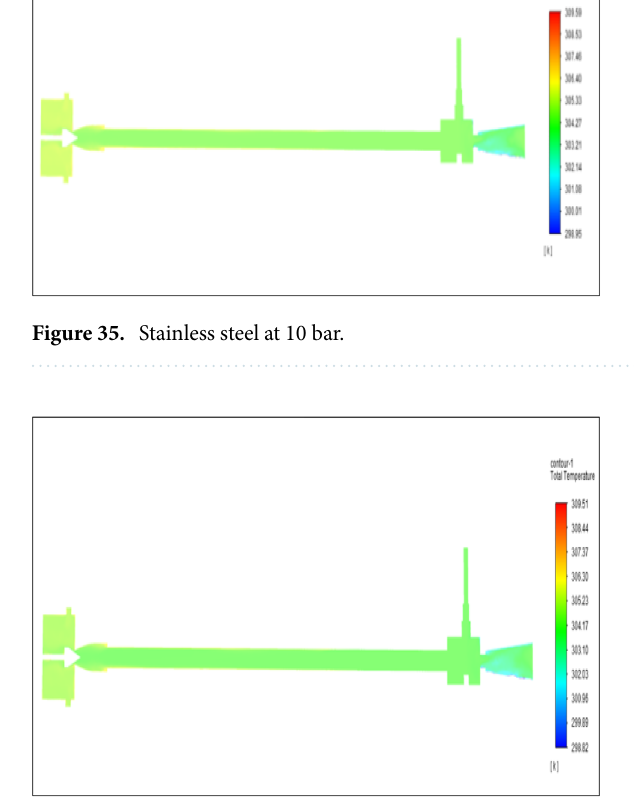
Figure 36. Brass at 10 bar.